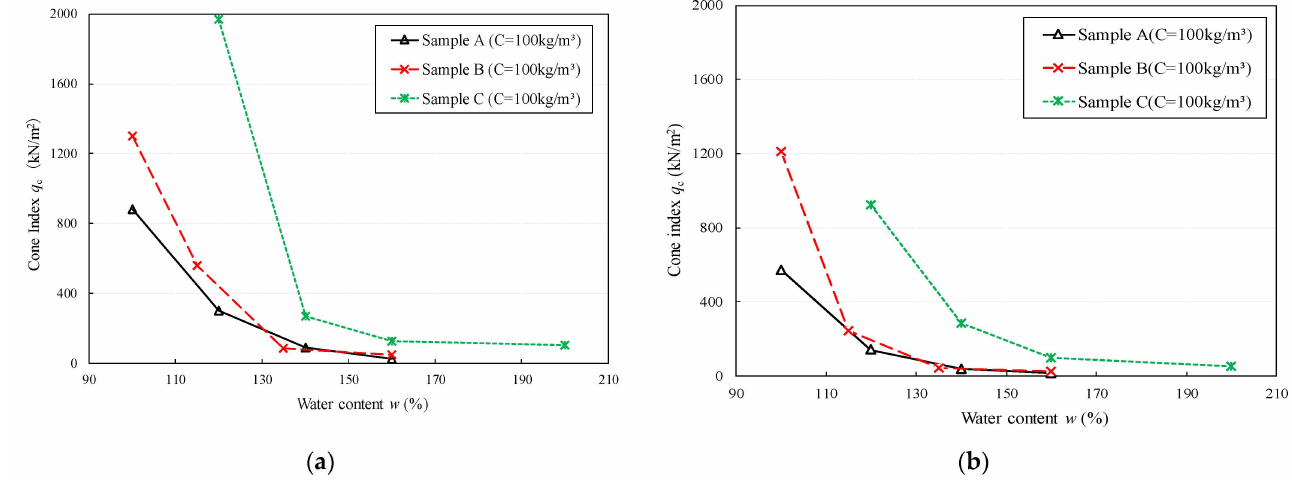
Figure 7. Relationship between cone index and water content at constant content of solidifying agent (100 kg/m 3 ). ( a ) Stabilized clay by OPC, ( b ) Stabilized clay by DF.